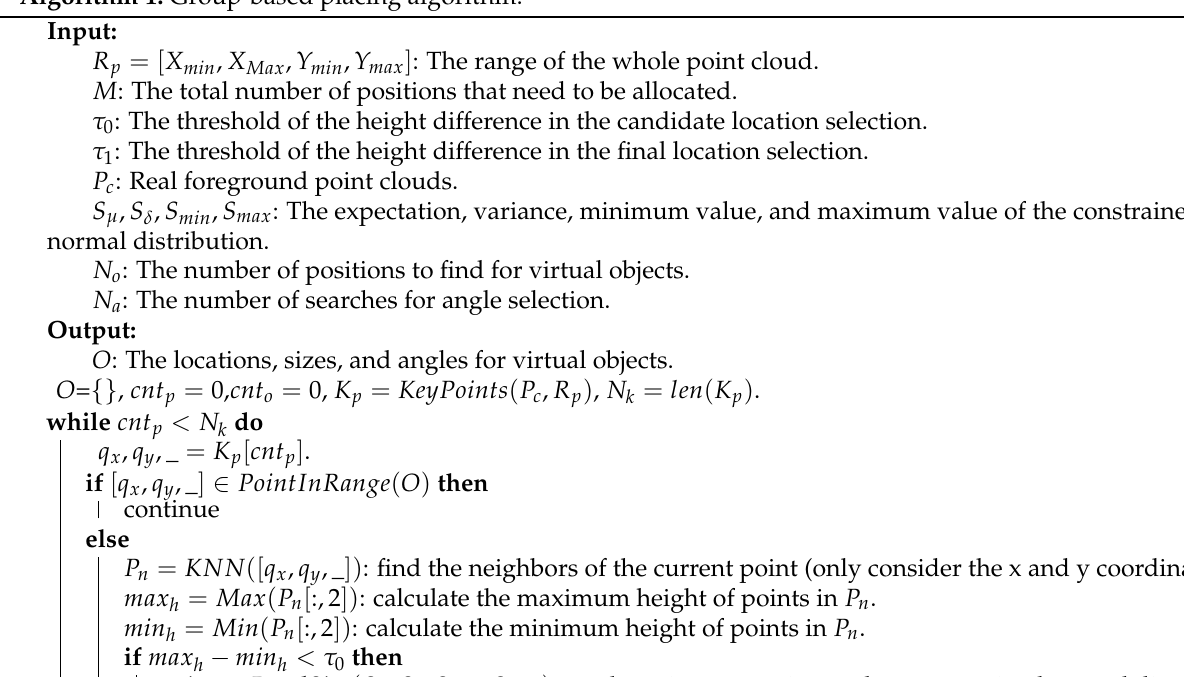
Algorithm 1: Group-based placing